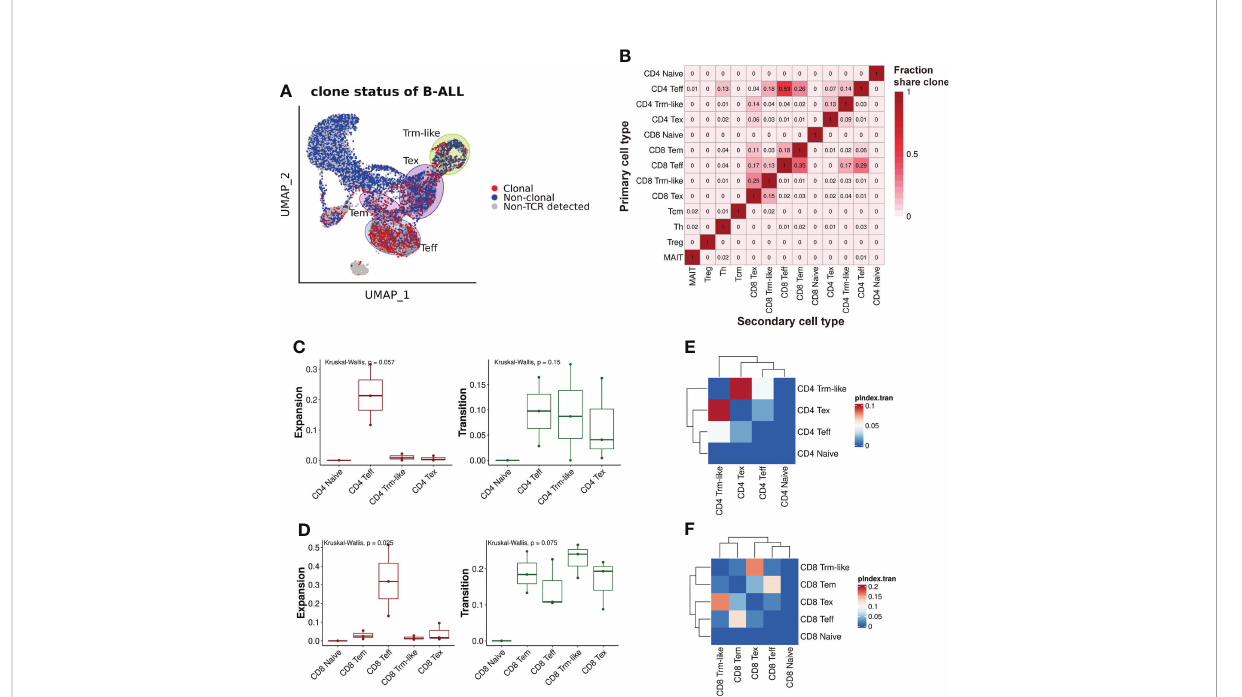
FIGURE 3 TCR ab clonotype characterization of T cells from B-ALL patients. (A) TCR ab clonal expansion status of T cells from B-ALL patients. (B). Summary of shared proportion of TCR clonotypes between T-cell subtypes. (C). Clonal expansion and transition ability comparison between CD4+ T-cell subsets of B-ALL patients. Kruskal – Wallis test. (D). Same as panel (C) but for CD8+ T-cell subsets. Kruskal – Wallis test. (E). Heatmap visualization of pairwise transition likelihood (based on clonotypes) of CD4+ T-cell subsets. (F). Same as panel (E) but for CD8+ T-cell